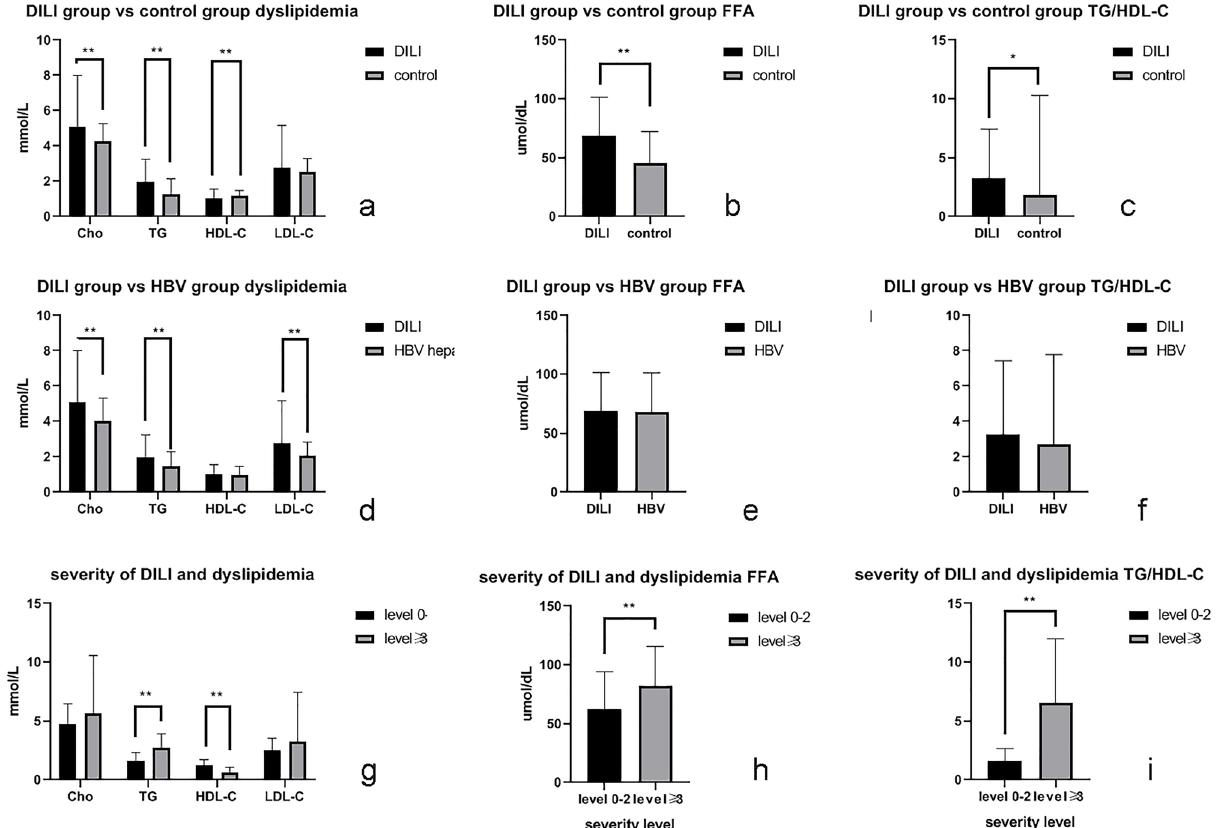
Figure 2. Dyslipidemia and TG/HDL-C ratio in DILI and control groups. TG triglyceride, Cho cholesterol, LDL-C low-density lipoprotein cholesterol, HDL-C high-density lipoprotein cholesterol, FFA free fatty acid, DILI drug induced liver injury. ( a ) Cho, TG, HDL-C and LDL-C levels in DILI and medication using control groups; ( b ) FFA level in DILI and medication using control groups; ( c ) TG/HDL-C ratio in DILI and medication using control groups; ( d ) Cho, TG, HDL-C and LDL-C levels in DILI and acute hepatitis B groups; ( e ) FFA level in DILI and acute hepatitis B groups; ( f ) TG/HDL-C ratio in DILI and acute hepatitis B groups; ( g ) Cho, TG, HDL-C and LDL-C levels in mild and severe DILI groups; ( h ) FFA level in mild and severe DILI groups; ( i ) TG/ HDL-C ratio in mild and severe DILI groups.*P ≤ 0.05, **P ≤